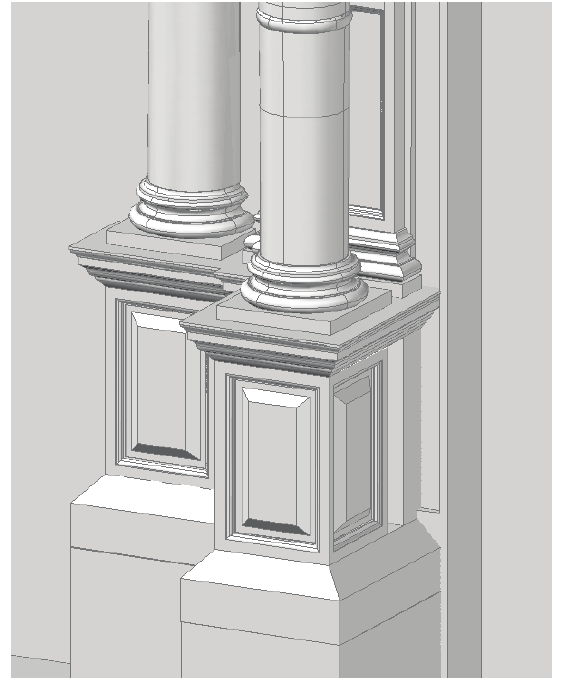
Figure 19. Pedestal polygonal model Figure 20. Pedestal geometric